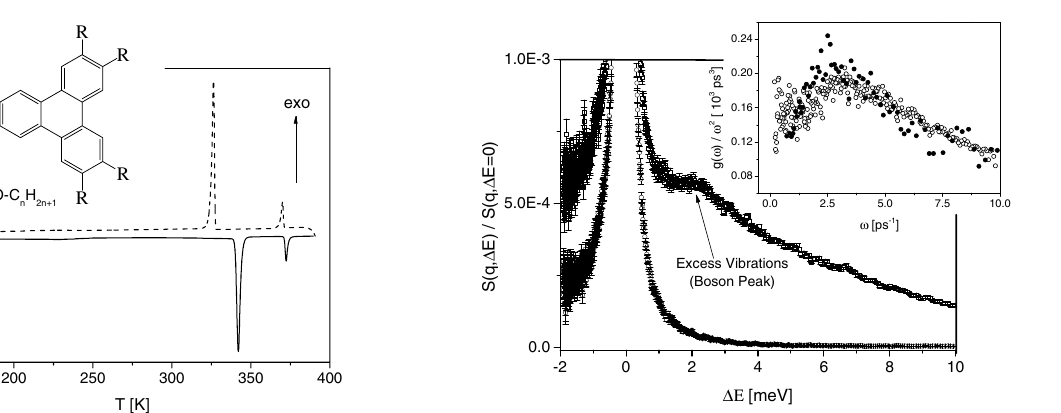
Figure 1. DSC thermogram for HAT6 during cooling (dashed line) and heating (solid line) at a rate of 10K/min. Inset: chemical structure of HATn. Table 1. Phase transition temperatures from the plastic crystalline to the hexagonal columnar phase T cry , col and from the hexagonal columnar phase to the isotropic phase T col , iso (second heating, heating rate of 10Kmin − 1 ).